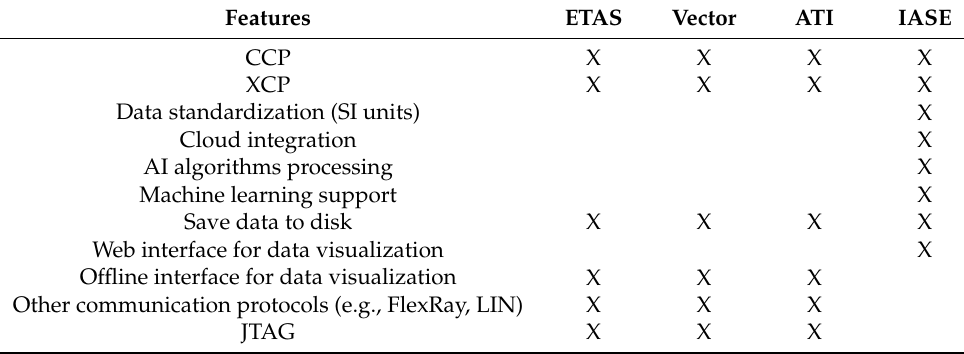
Table 1. Comparison of features of the commercial systems and